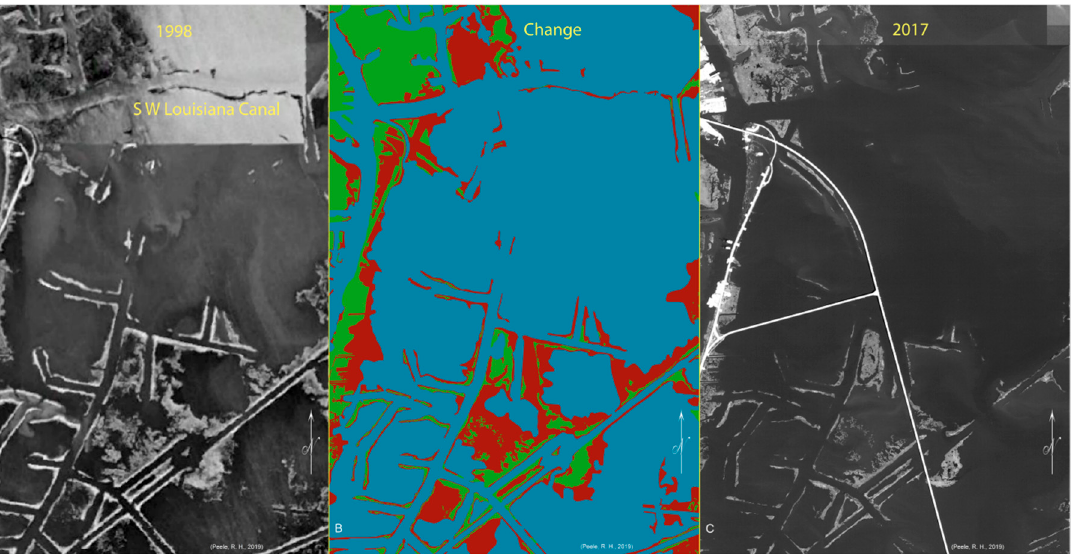
Figure 10. Aerial imagery of a portion of the Leeville oil and gas field in southern Louisiana showing the disappearance of spoil banks and marsh between 1998 and 2017. Bayou Lafourche is in the upper left in each of the images [5]. Areas depicted in red in image B disappeared between the two dates. Red linear strips are spoil banks that disappeared. Green shows subaerial land, both spoil banks and marsh, that was still present in 2017. The Southwest Louisiana Canal at the top of image A was dredged in the late 19th century. In 1998, some spoil banks along the canal were still present, but by 2017 they had disappeared. Louisiana highway 1 is shown at the upper left in image A. By 2017, a new, elevated highway was constructed (white lines in Image C). The width of images is approximately 2.8 km.